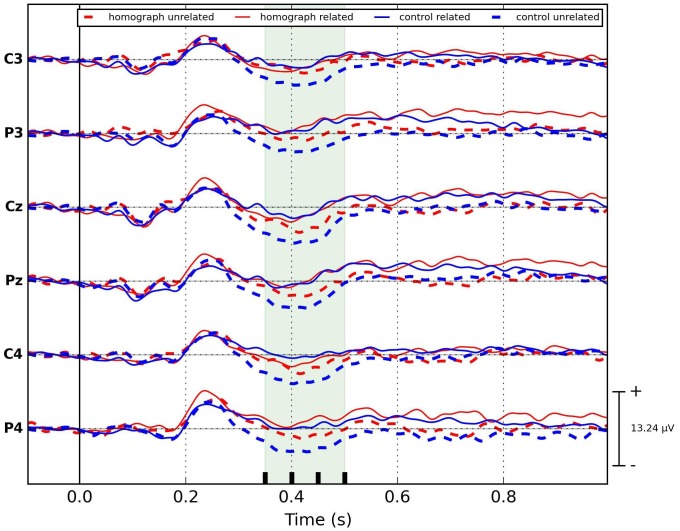
ERP plots for all stimulus groups for short experimental version.N400 time range is shaded. Significant priming effect is presented for the homograph unrelated stimulus group.